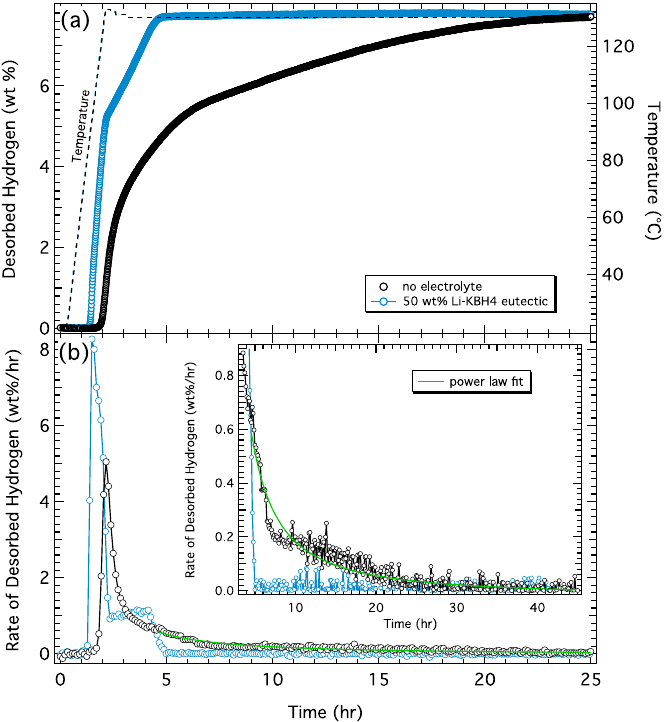
Figure 5. ( a ) Hydrogen desorption from 50 / 50 wt% LiAlH 4 / Li-KBH 4 eutectic (blue) and LiAlH 4 control samples (black). Corresponding temperature profiles are indicated by the dashed lines. ( b ) Rate of desorbed hydrogen from both samples calculated from the derivative of the desorption curve with a magnified and expanded region of the data set shown in the inset. Green curve is a power law fit to the continuously slowing desorption in the control sample.